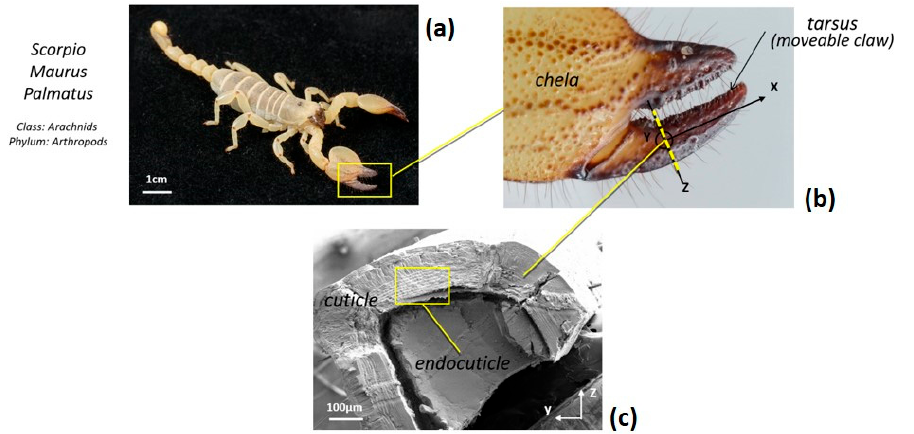
Figure 3. ( a ) General view of the Scorpio maurus palmatus (SP); ( b ) Detail of the tibia (chela); ( c ) SEM view of the cross-section revealing the layered structure of the endocuticle.